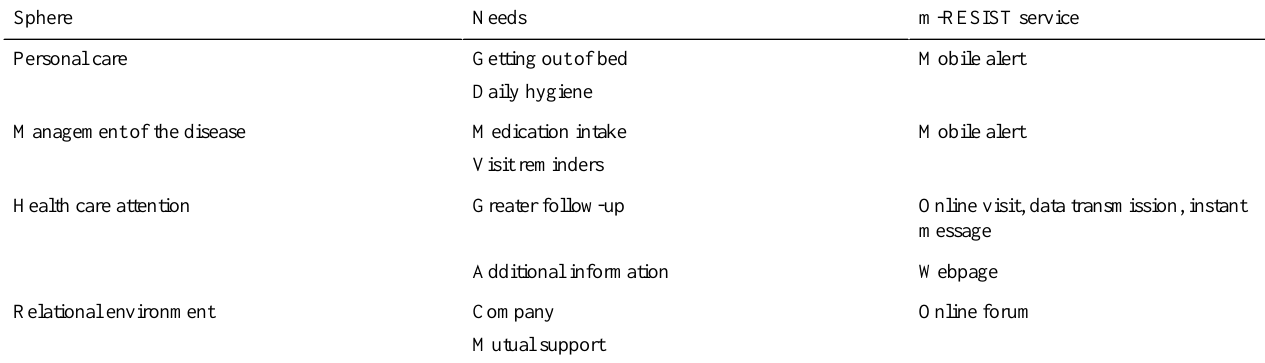
Table 2. Relation between perceived needs and the m-RESIST a